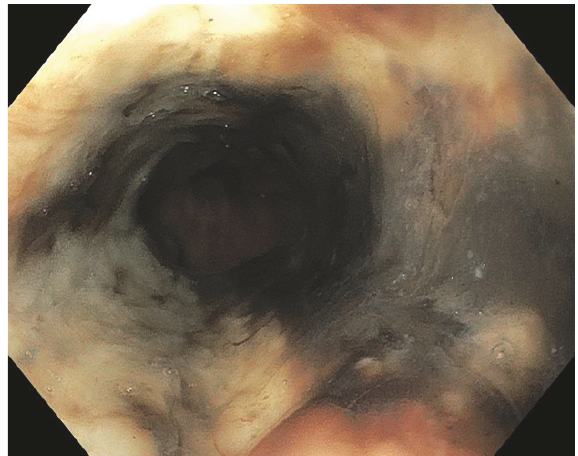
Figure 1: LA Grade D esophagitis extending to the middle esopha- gus.